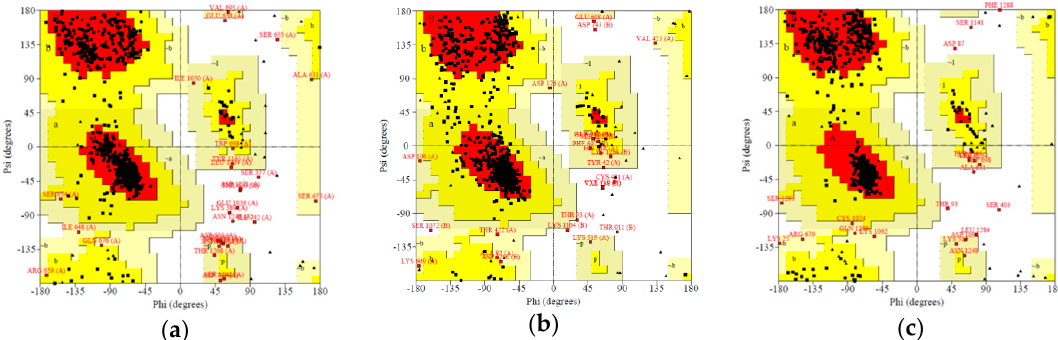
Figure 5. Ramachandran Plots for the modeled 3D structures of the h P-gp. The red, yellow and white areas represent the favored, allowed and disallowed regions respectively: ( a ) model generated by SWISS-MODEL tool; ( b ) model generated by I-TASSER tool; ( c ) model generated by Discovery Studio 4.1 Client/Modeler 9.12 tool. Table 5. Ramachandran Plot Statistics for the h P-gp models and the crystal structure of m P-gp (PDB: